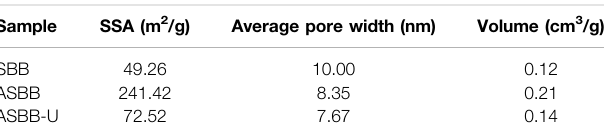
TABLE 5 | Surface aperture